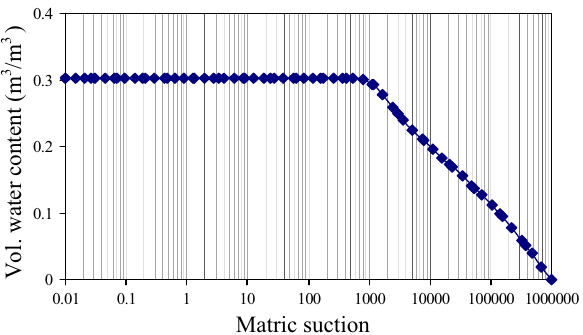
Figure 3: SWCC of gypseous soil. Figure 4: Hydraulic - conductivity curve of gypseous